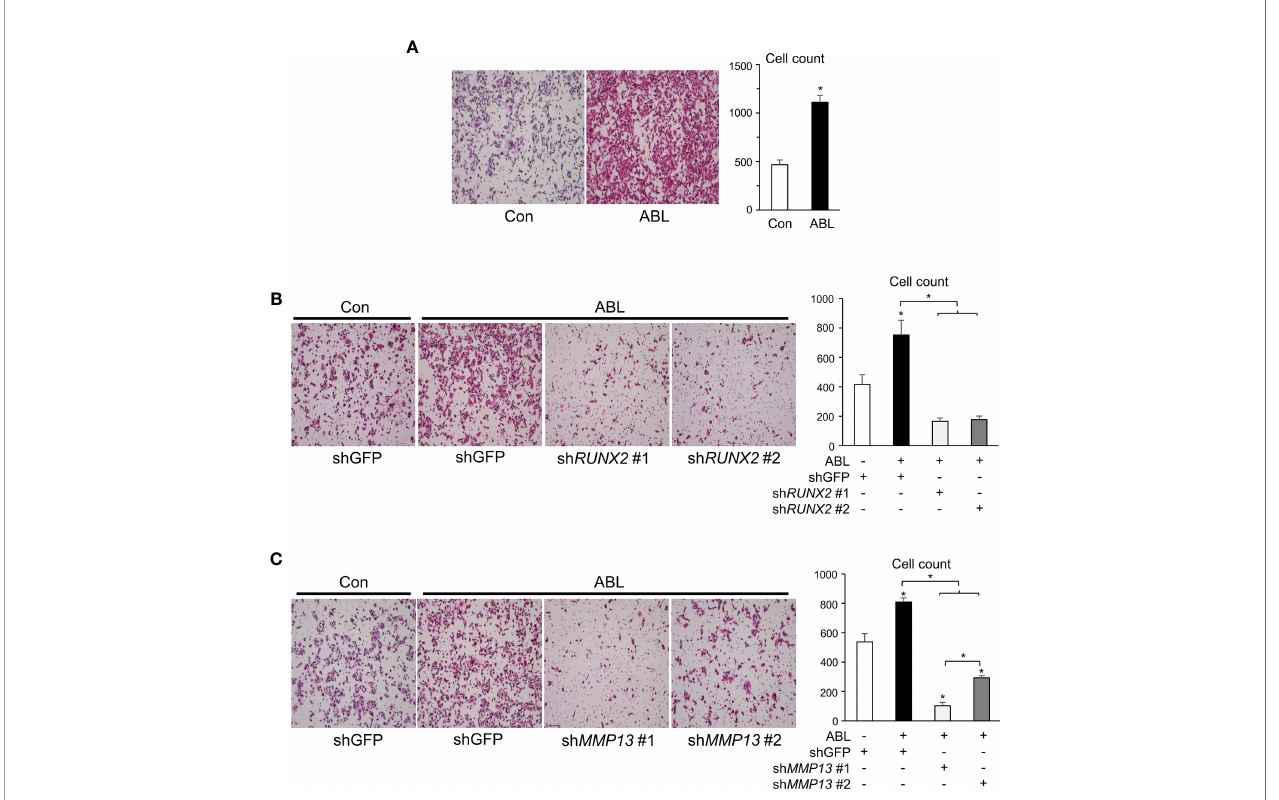
FIGURE 5 | Invasive activity accelerated by ABL is rescued in RUNX2- or MMP13-depleted breast cancer cells. (A) MDA-MB231 cells co-transfected with or without ABL were subjected to a Matrigel invasion assay, and invading cells in fi ve independent regions were counted. Representative photographs were taken at 10 × magni fi cation. (B) MDA-MB231 cells co-transfected with or without ABL were infected with an shGFP- or sh RUNX2 -expressing vector and subjected to a Matrigel invasion assay. Invading cells in fi ve independent regions were counted. Representative photographs were taken at 10 × magni fi cation. (C) MDA-MB231 cells co-transfected with or without ABL were infected with an shGFP- or sh MMP13 -expressing vector and subjected to a Matrigel invasion assay. Invading cells in fi ve independent wound regions were counted. Representative photographs were taken at 10 × magni fi cation. P values were determined by the unpaired t-test (A) or ANOVA with Tukey – Kramer ’ s post hoc test (B,C). Data are presented as means ± SEM. *P <